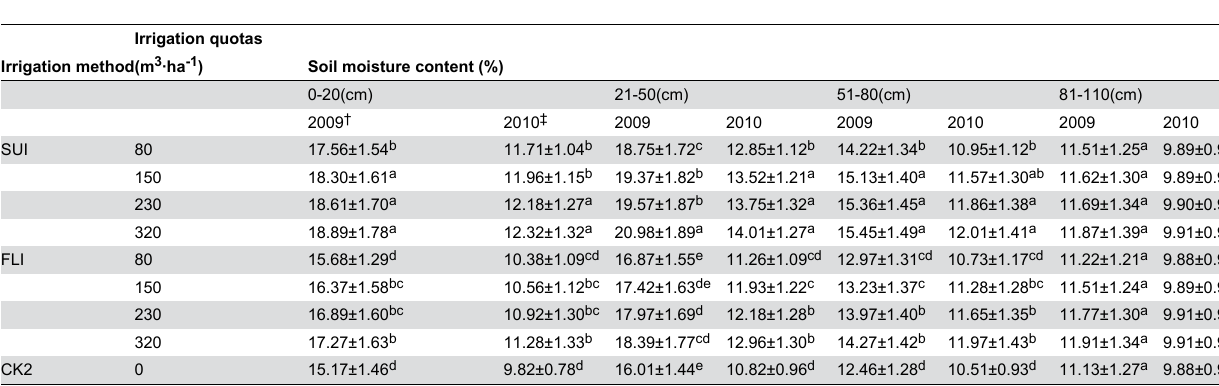
Different small letter means P <0.05; “†” The soil moisture content is the average values for the different SUI and FLI quotas on 26 April and 18 May in 2009; “‡ ” The soil moisture content is the average values for the different SUI and FLI quotas on 15 April, 20 May and 5 June in 2010. CK2 means the irrigation quotas is 0 m 3 ·ha - 1 (no-water